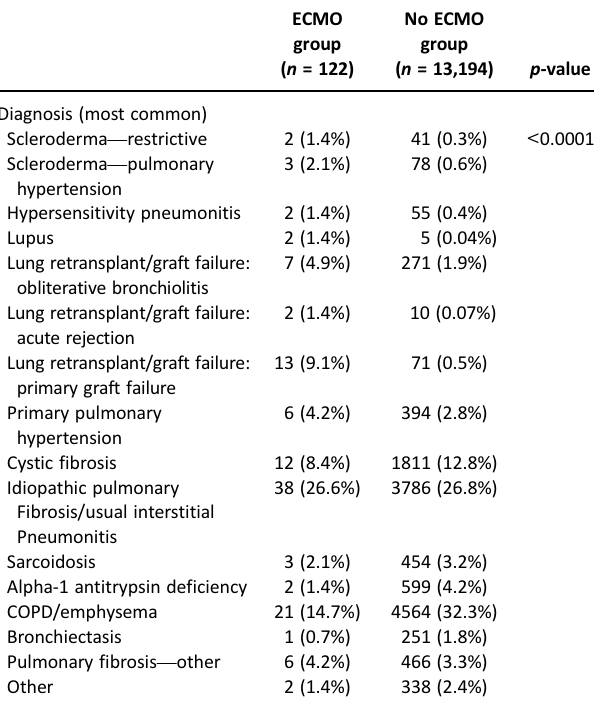
Table 4. Recipient diagnosis.